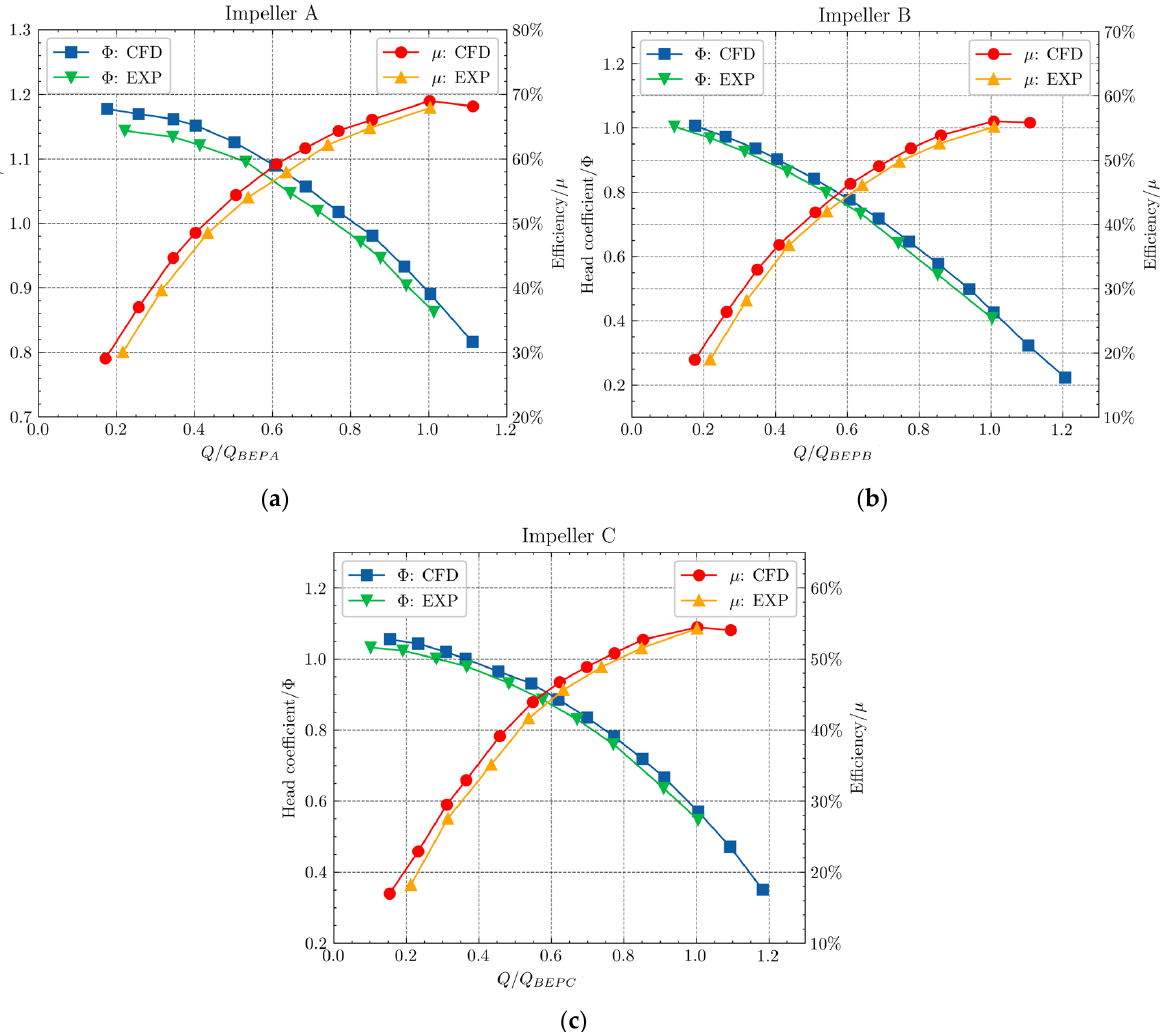
Figure 11. Comparison of predicted and tested hydraulic performance curves of the pumps: ( a ) Case A impeller, ( b ) Case B, and ( c ) Case A impeller.